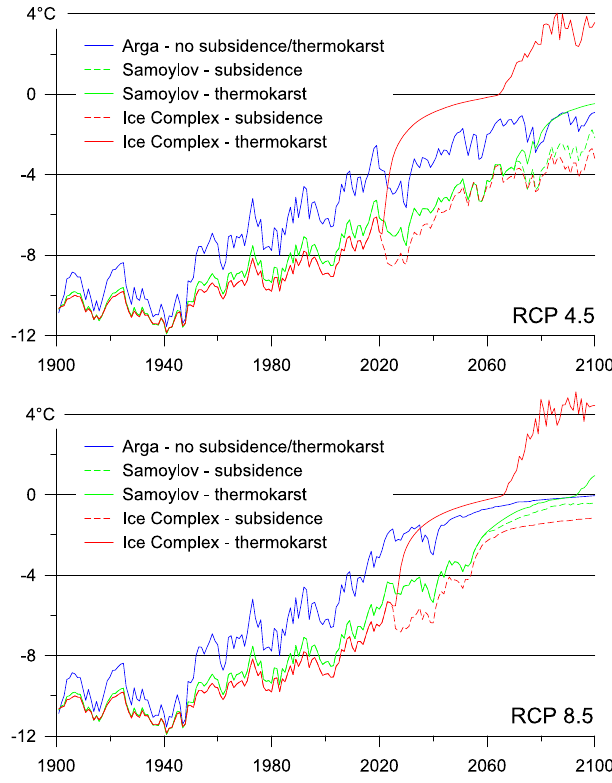
Figure 9. Annual average temperatures at 10m below the ground surface (i.e., the actual ground surface in case of subsidence) for the years 1901–2100; two future warming scenarios and three different (cryo-)stratigraphies of the